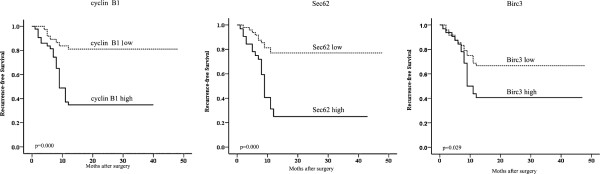
The clinical significance of cyclin B1, Sec62, and Birc3 expressions in the patients with HCC surgery. Kaplan-Meier curves were used to estimate the recurrence-free survival rates according to the expression levels of cyclin B1, Sec62, and Birc3 in the 80 HCC patients who underwent surgery. Cyclin B1 (left), Sec62 (middle), and Birc3 (right).